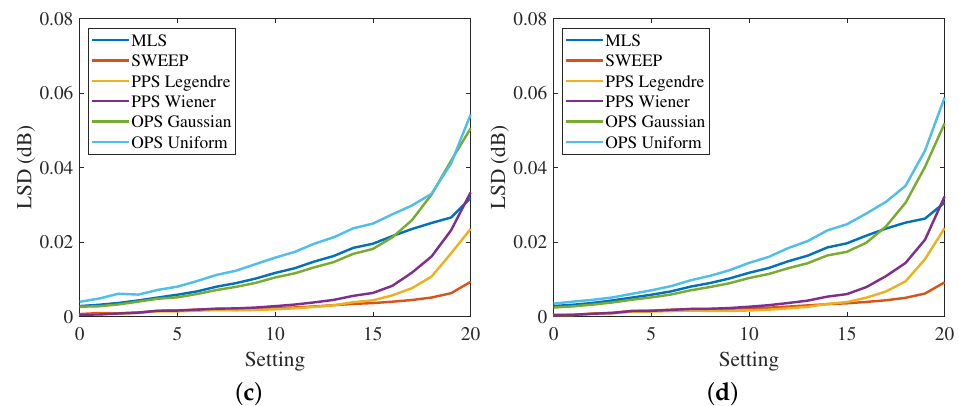
Figure 7. Log-spectral distance in the band [100, 18000] Hz at the different settings with the MIC-100 preamplifier for ( a ) the response of the left ear from the left speakers, ( b ) the response of the left ear from the right speakers, ( c ) the response of the right ear from the left speakers and ( d ) the response of the right ear from the right speakers, and no artificially added noise, i.e., with SNR larger than 60 dB.